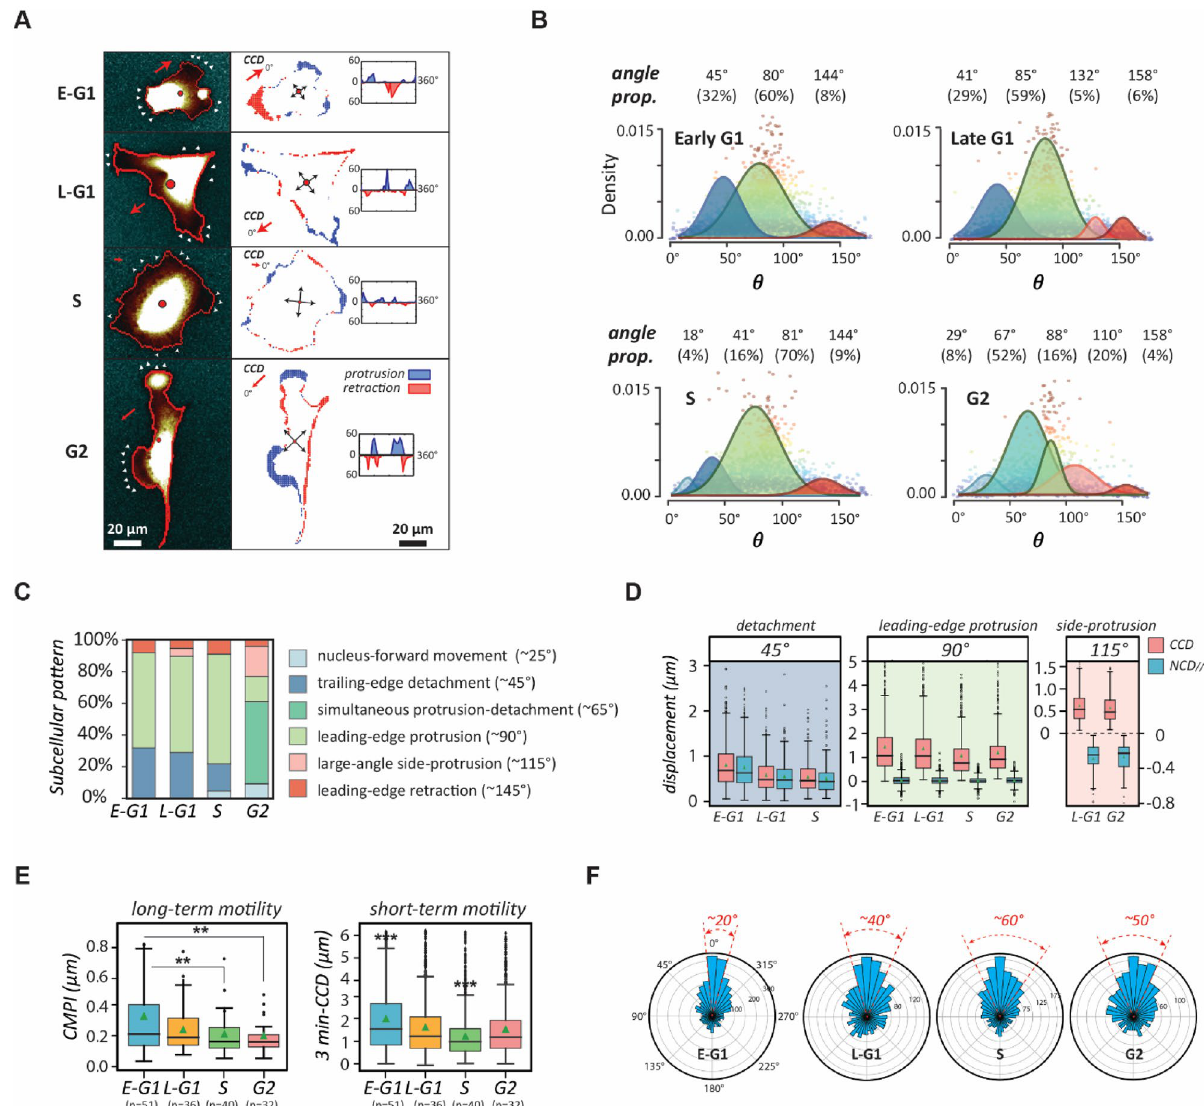
Figure 3. The transition of natural migration patterns of NIH 3T3 fibroblasts over the cell cycle. ( A ) Graphic of typical spreading patterns of NIH 3T3 fibroblasts in each stage of the cell cycle phases. Cell migratory dynamics can be assessed by peripheral variations in the polar coordinate in which cell centroid is set as the origin—left column: fluorescent cell images in different stages of the cell cycle phases; right: the occurrences of protrusions (blue) and detachments (red) in the corresponding synchronized cell edges; insert: the distribution of protrusion and retraction. ( B ) The decomposed UNM signature plots of synchronized cells showing cell migration patterns in different stages of the cell cycle phases, where the peak polar angle of each normal distribution represents a distinct subcellular activity with a specific weight. ( C ) Cell migration patterns of NIH 3T3 fibroblasts decomposed into different subcellular events. ( D ) Box plots of CCD and NCD // in each signature polar angle zones, representing the magnitude of distinct subcellular events. ( E ) Cell motilities in different stages of the cell cycle phases, estimated using the Cell Migration Potential Index (CMPI) for the long-term and three-minute CCD speed for the short-term. ( F ) Cell migration polarity in different stages of the cell cycle phases, evaluated by the one-minute CCD direction histogram. Data information: *** indicates that the group of data is statistically significant compared to other groups. The related statistical results of this figure are listed in Supplementary Table